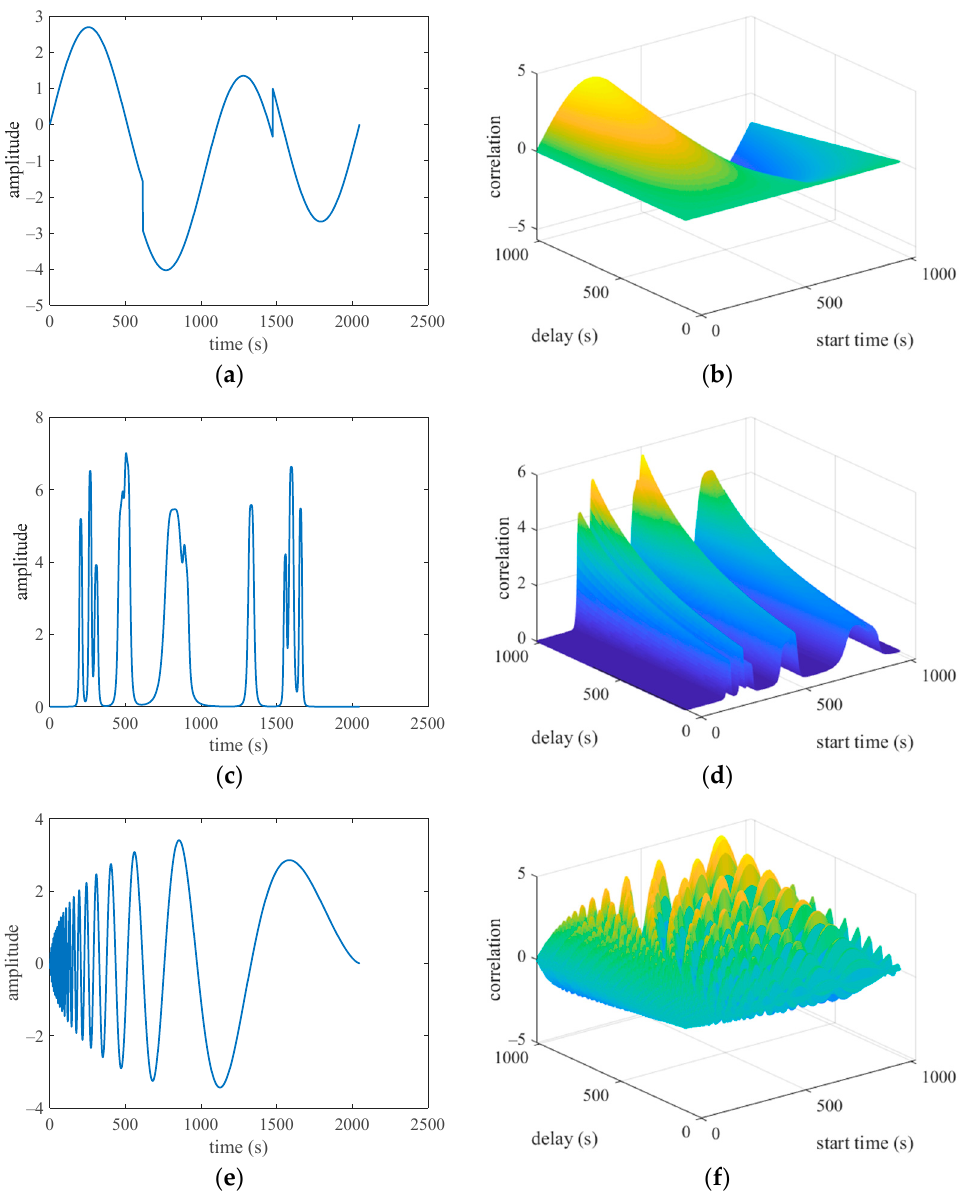
Figure 3. Common nonstationary signal waveforms and their autocorrelation functions (panels ( a , c , e ) are waveform of the heavy sine signal, bumps signal and Doppler signal, and panels ( b , d , f ) are autocorrelation function of the heavy sine signal, bumps signal and Doppler signal).